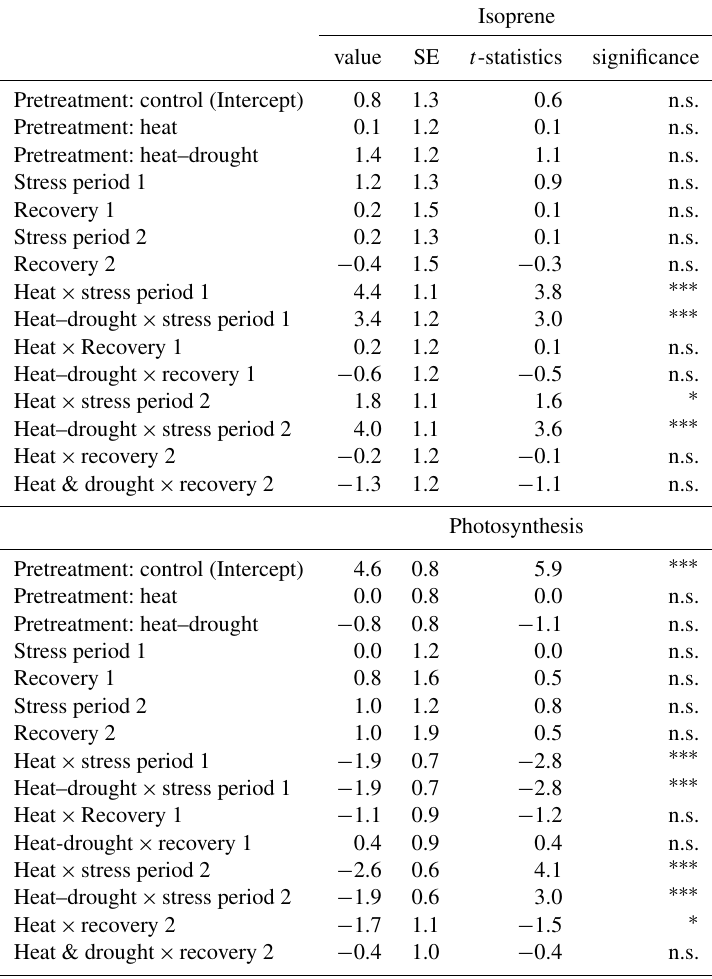
Table 2. Results of a linear mixed effects model evaluating isoprene emissions and daytime photosynthesis under different treatments and for different time periods during the experiment (pretreatment, heat period 1, recovery1, heat period 2 and recovery 2). The model tests for interactions between treatment and time period relative to control conditions ( ∗∗∗ corresponds to a p< 0 . 005 and ∗ corresponds to a p -value between 0.05 and